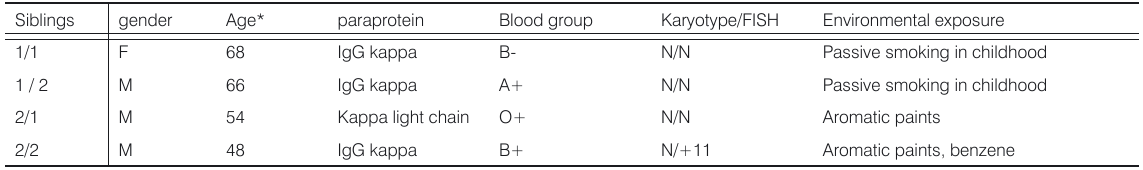
Table 1. Clinical data of the two multiple myeloma sibling pairs.